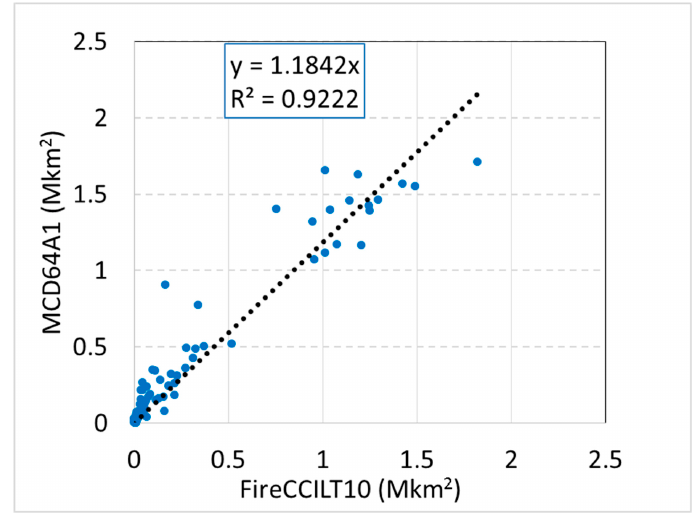
Figure 14. BA estimations of the MCD64A1 and FireCCILT10 products for the continental regions.